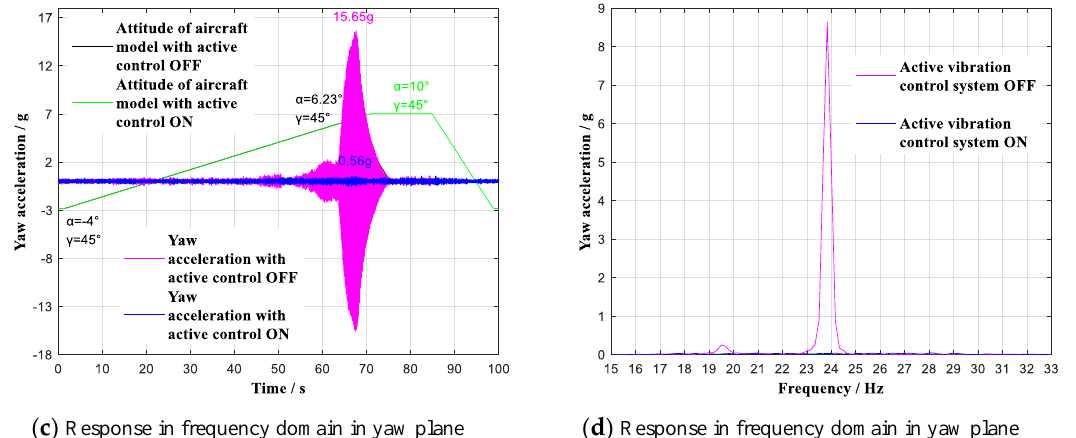
Figure 14. Vibration with multidimensional vibration suppression system off and on lifting continuous (γ = 45°) at 0.7 Ma. ( a ) Response in time domain in pitch plane; ( b ) Response in frequency domain in pitch plane; ( c ) Response in frequency domain in yaw plane; ( d ) Response in frequency domain in yaw plane.